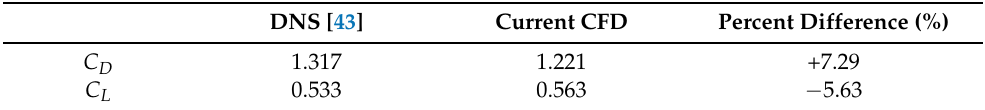
Table 4. Force Coefficients Predicted by Current Simulation at Re = 5610 Compared to DNS Calculations of Curly and Uddin [43].